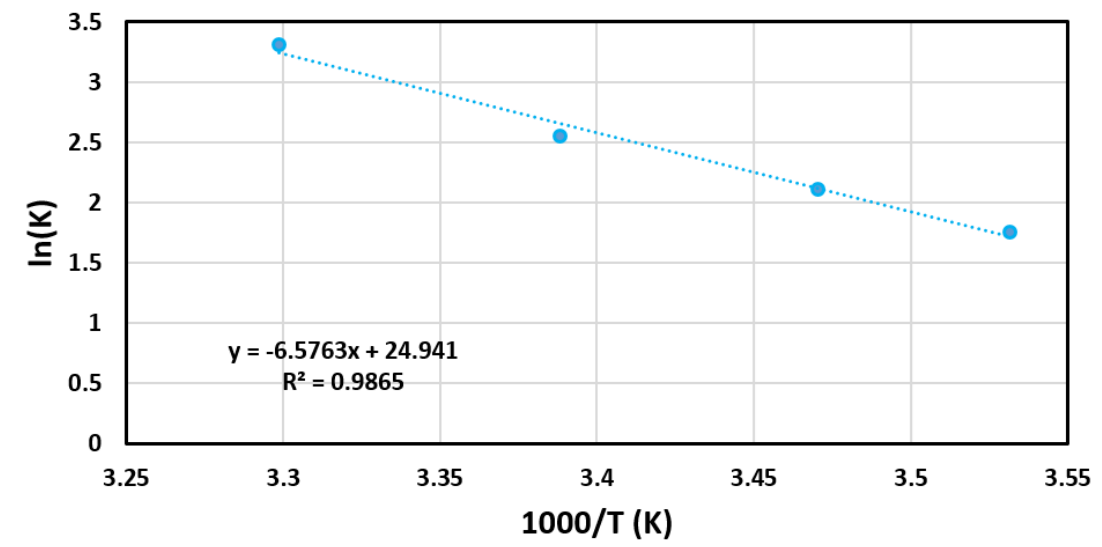
Figure 9. Arrhenius Plot used in association with Equation (2) to determine the activation energy of the NaBH 4 reaction catalyzed by the BCD − AuNPs.